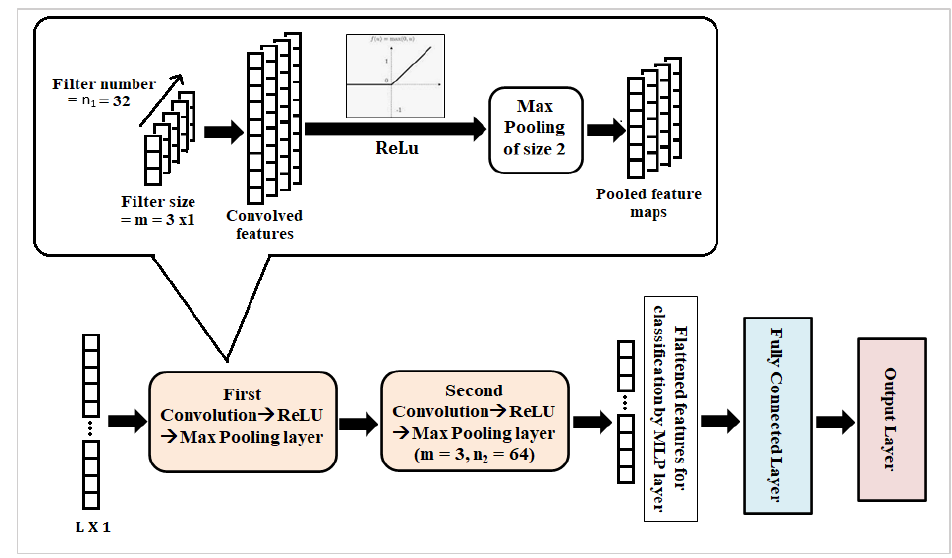
Figure 3. Architecture of the proposed CNN model. Here, m = size of convolution kernel, n 1 = number of kernels in the first convolution layer and n 2 = number of kernels in the second convolution layer.